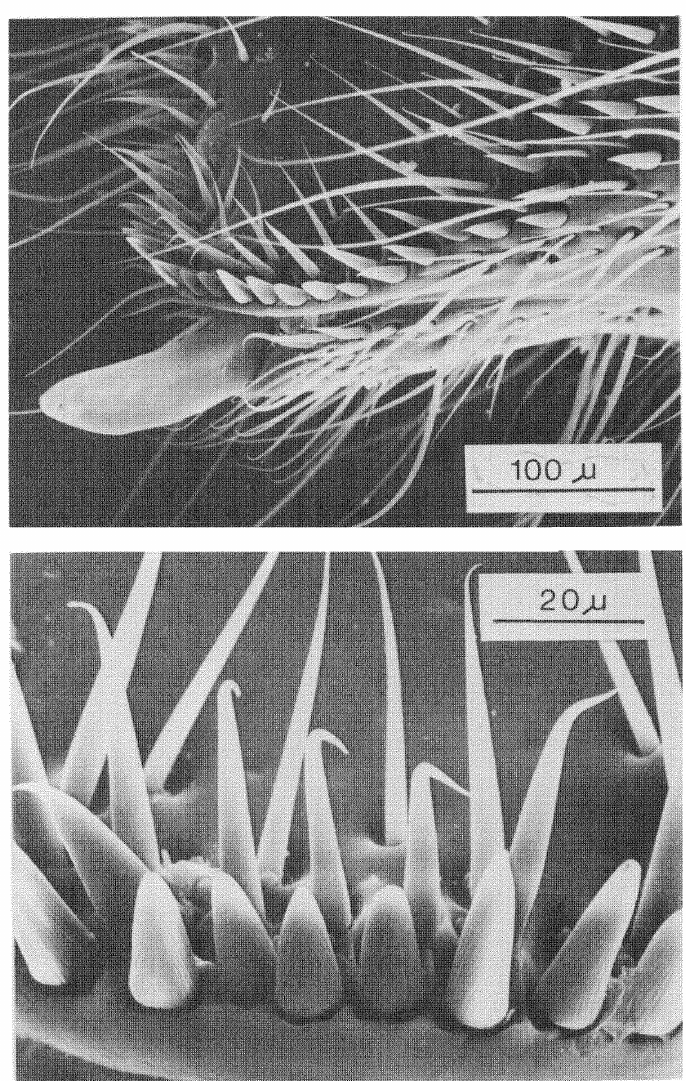
Figure 5. (a) SEM picture of the abdominal tip of a Cerapach)’s worker. The picture shows the partly extruded sting, surrounded by the sensory setae at the pygidium, and last exposed sternite. (b) Close-up of the two kinds of setae at the